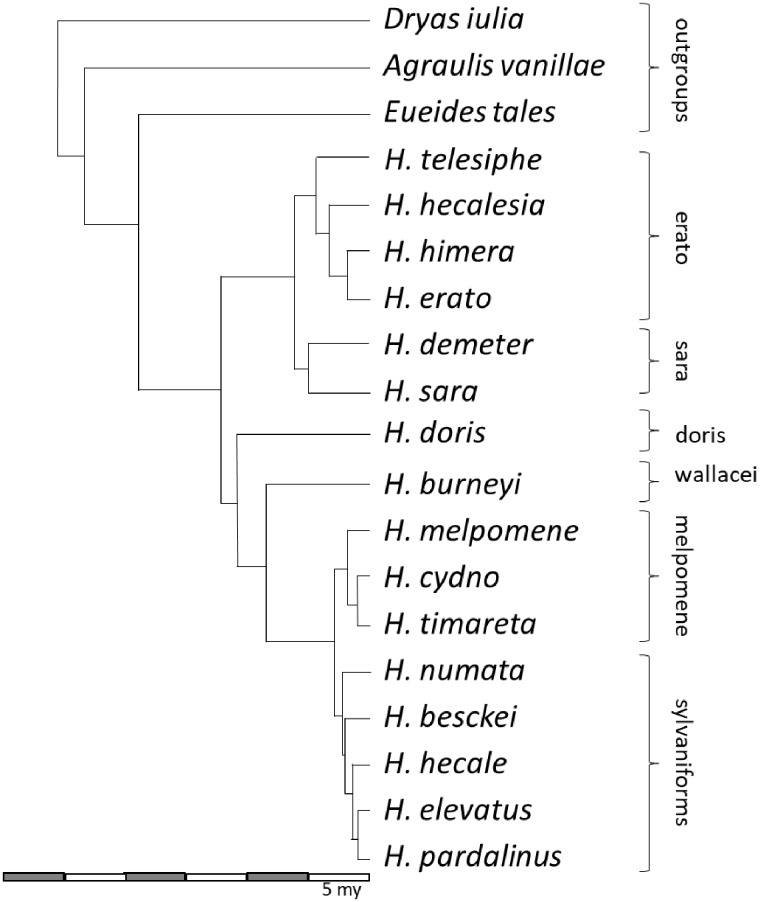
—Phylogeny of the taxa examined, modified from Kozak et al. (2015). Subclade memberships are identified to the right of the tree.